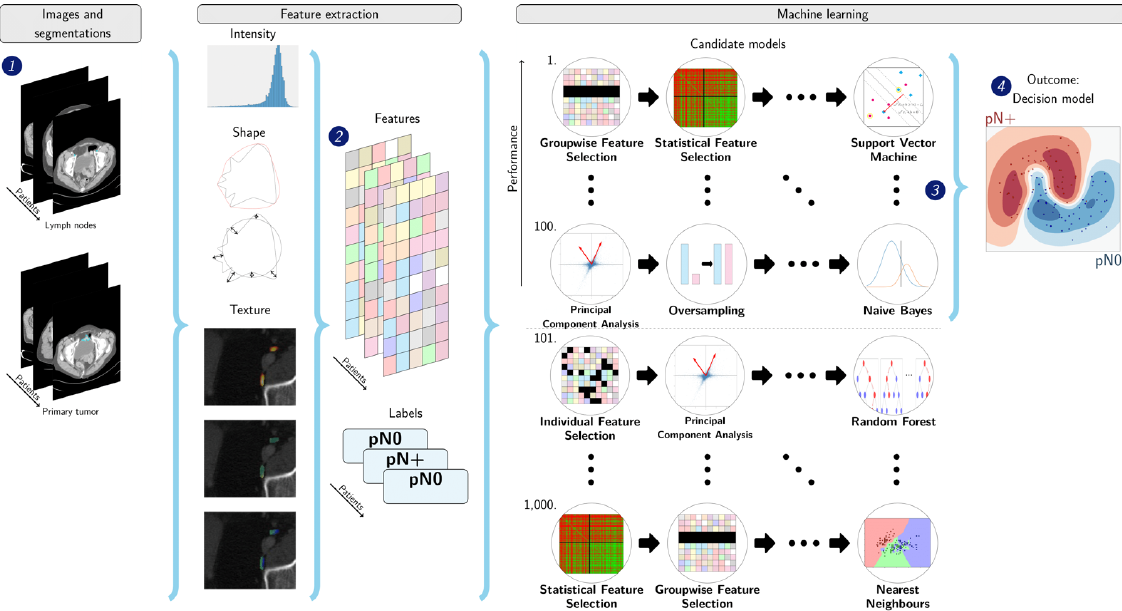
Figure 1. A schematic overview of the radiomics approach]. Inputs to the analyses were computed tomography (CT) of abdomen or CT urogram and corresponding segmentations of the lymph nodes (1). From these segmentations, 564 features quantifying intensity, shape and texture were extracted (2). A decision model was created (4) using the 100 best performing models (3) of 1000 candidate models. Adapted from Vos et al. [39]: the images under (1), texture features, numbers at (3), and output at (4) have been modified with respect to the original